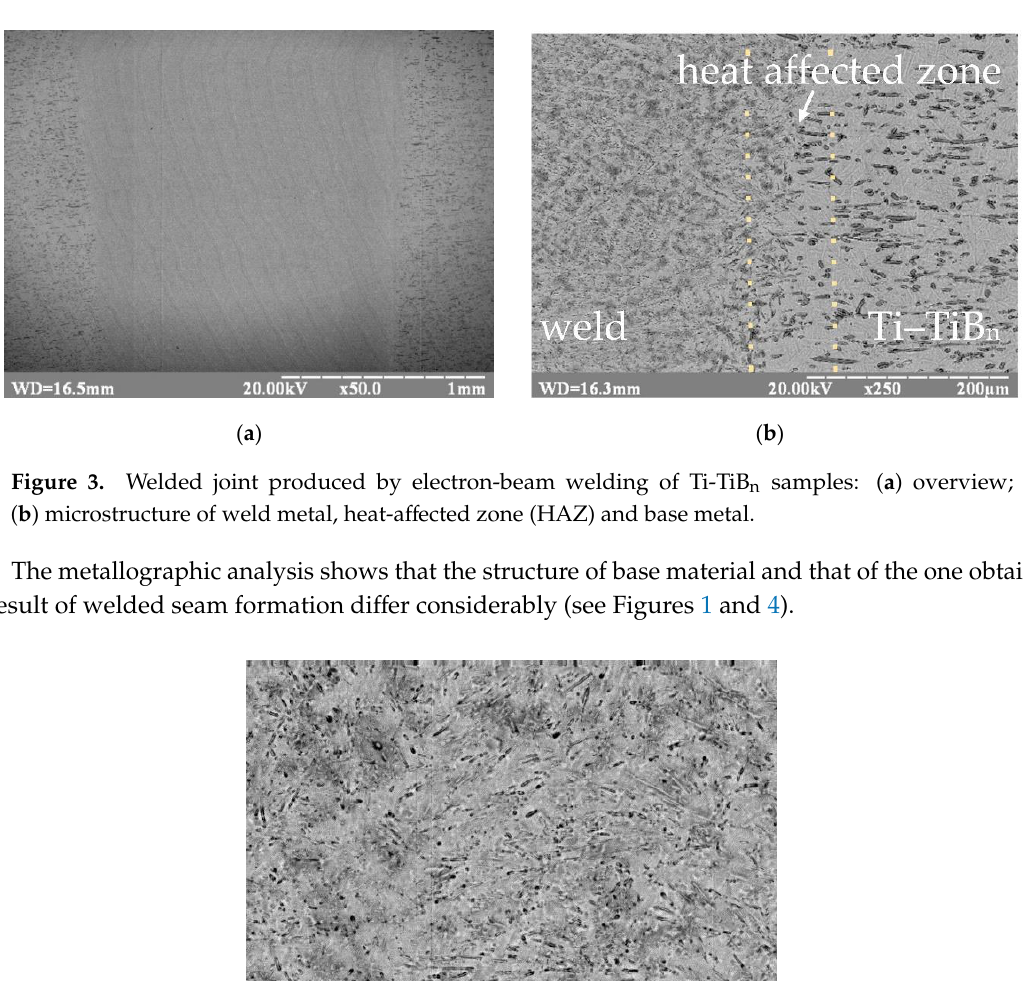
Figure 4. Typical structure of Ti-TiB alloy in the weld metal after welding.